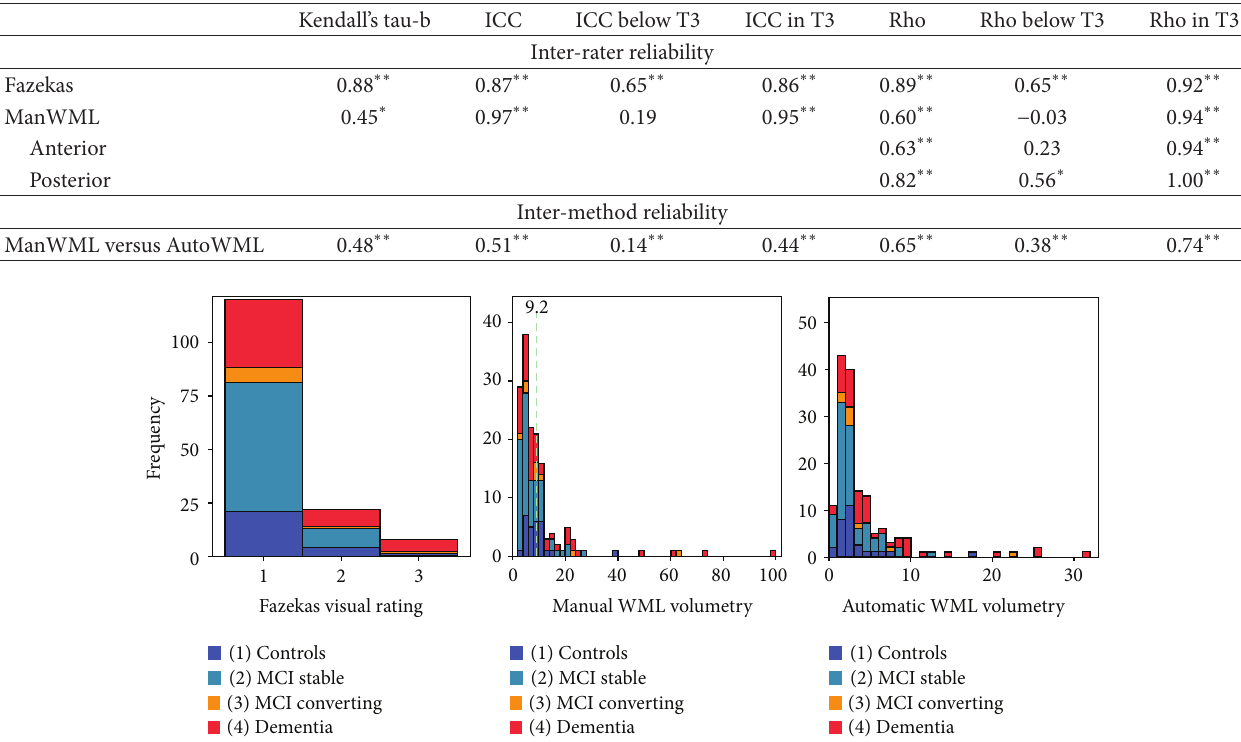
F 2: Histograms of WML distribution in the three methods compared. (a) Fazekas visual rating (grade). (b) Manual MRIcron volumetry